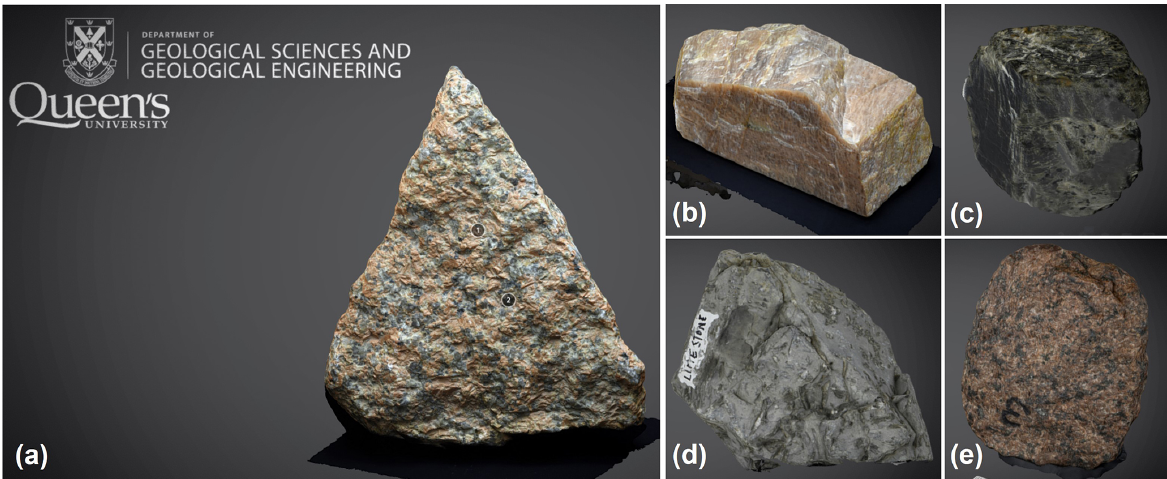
Figure 6. Examples of hand sample 3D photogrammetry models created by the Department of Geological Sciences and Geological Engi- neering at Queen’s University (GSGEQueens, 2020). (a) Granite. (b) Potassium feldspar. (c) Amphibole. (d) Limestone. (e) Syenite.